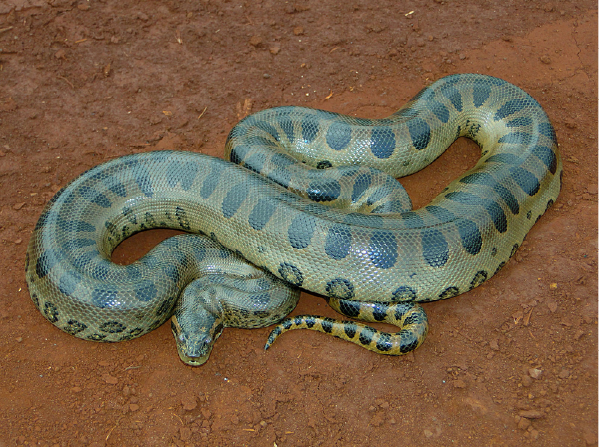
Figure 1. Green anaconda (https://upload.wikimedia.org/wikipedia/commons/b/b4/Sucuri_verde.jpg (accessed on 03/11/2023)) taken from: free media Wikimedia Commons.